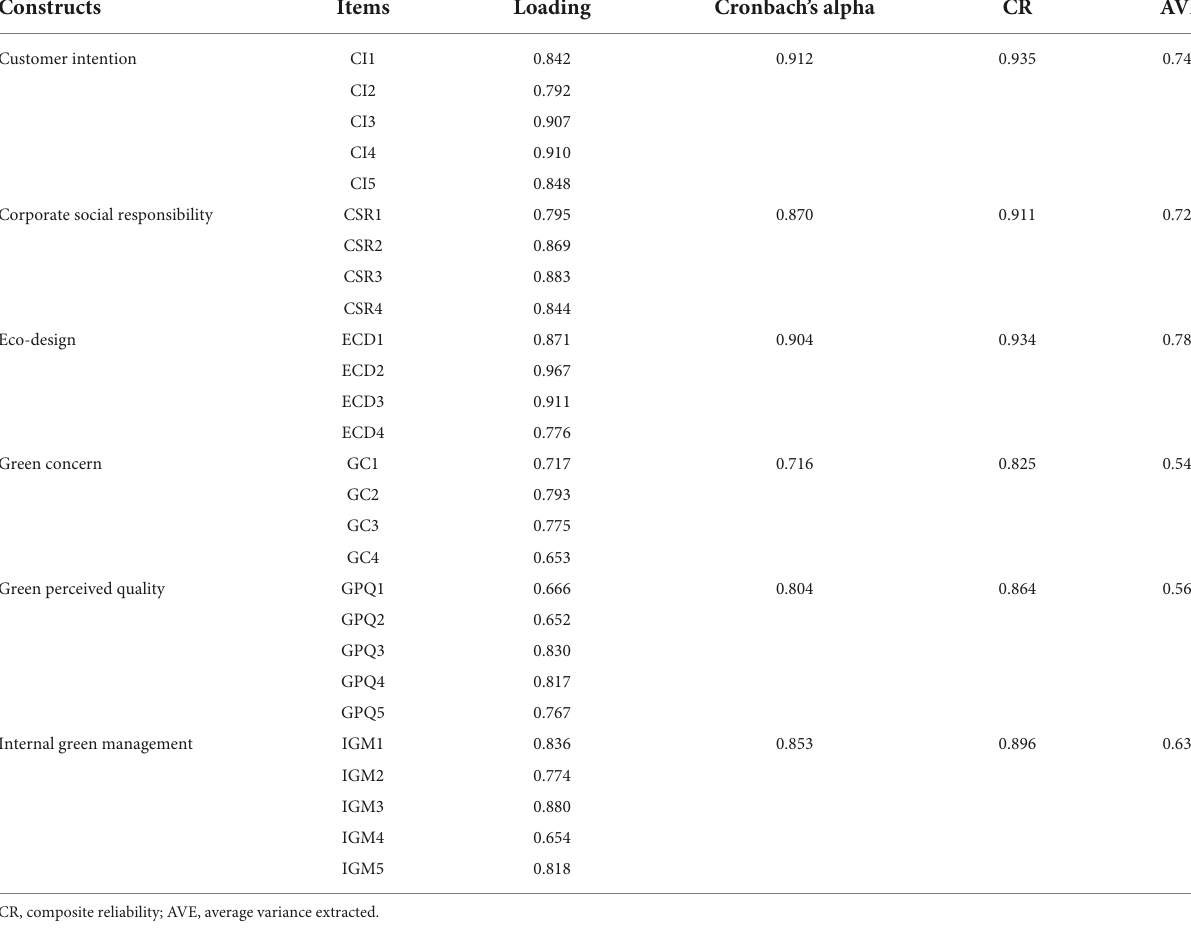
TABLE 3 Reliability testing and convergent validity.